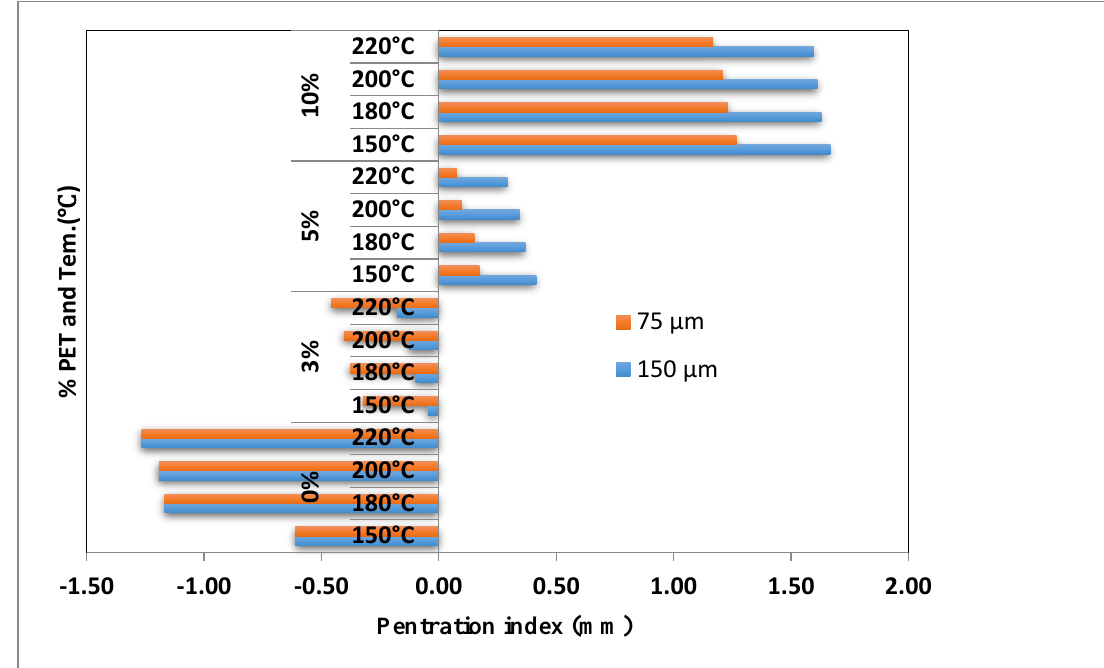
Figure 2. PET content, Tem vs. PI value of asphalt binder.